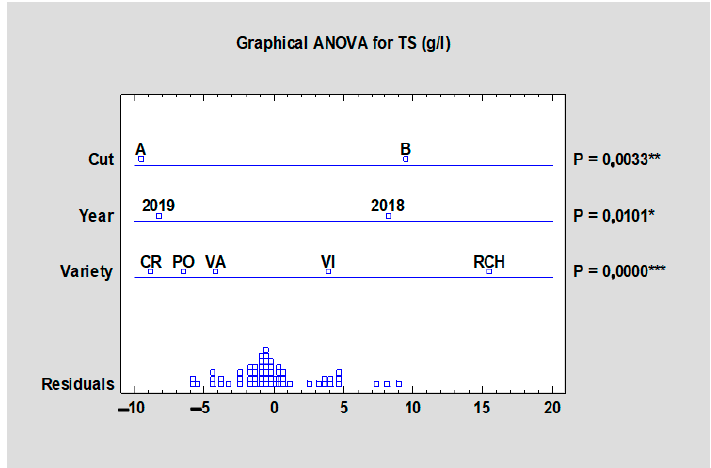
Figure 7. Effect of the experimental year, cultivar, and term of the harvest on the total sugar content of all rhubarb cultivars. Abbreviations: PON, ‘Poncho’; CRE, ‘Canadian Red’; VAL, ‘Valentine’; RCH, ‘Red Champagne’; VIC, ‘Victoria’. LSD test with significance: non-significant (NS) or significant at p ≤ 0.05 (*), p ≤ 0.01 (**), or p ≤ 0.001